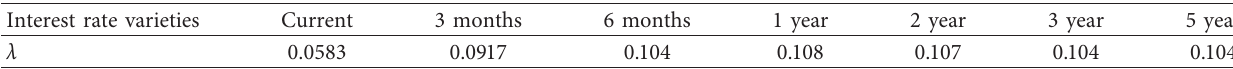
Table 6: Jump intensity of time deposit interest rate of each